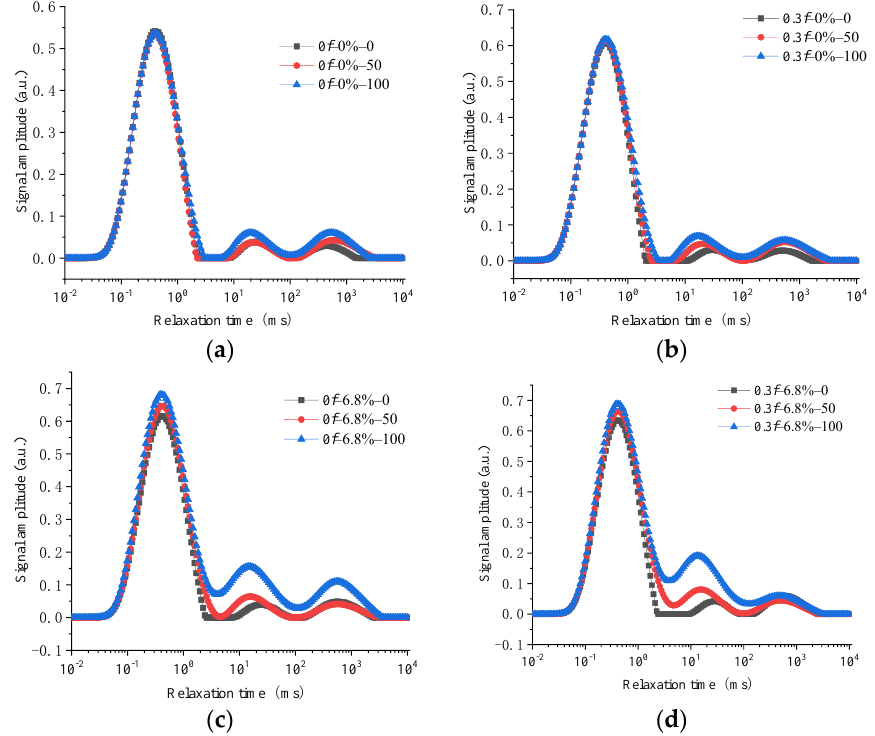
Figure 8. T2 spectra for various relaxation times and numbers of freeze–thaw cycles. ( a ) Without an initial load in the freshwater. ( b ) After an initial load of 0.3 f in freshwater. ( c ) Without an initial load in a 6.8% composite salt solution. ( d ) After an initial load of 0.3 f in a 6.8% composite salt solution. The transverse coordinate in the T2 spectrum represents the relaxation time and is shown by logarithmic coordinates. The relaxation time reflects the diameter of a hole in a material. The longer the relaxation time in the transverse coordinates, the greater the pore diameter. The ordinates in the T2 spectrum represented the signal intensity of the NMR inversion of the pores, and the value of the signal intensity characterized the